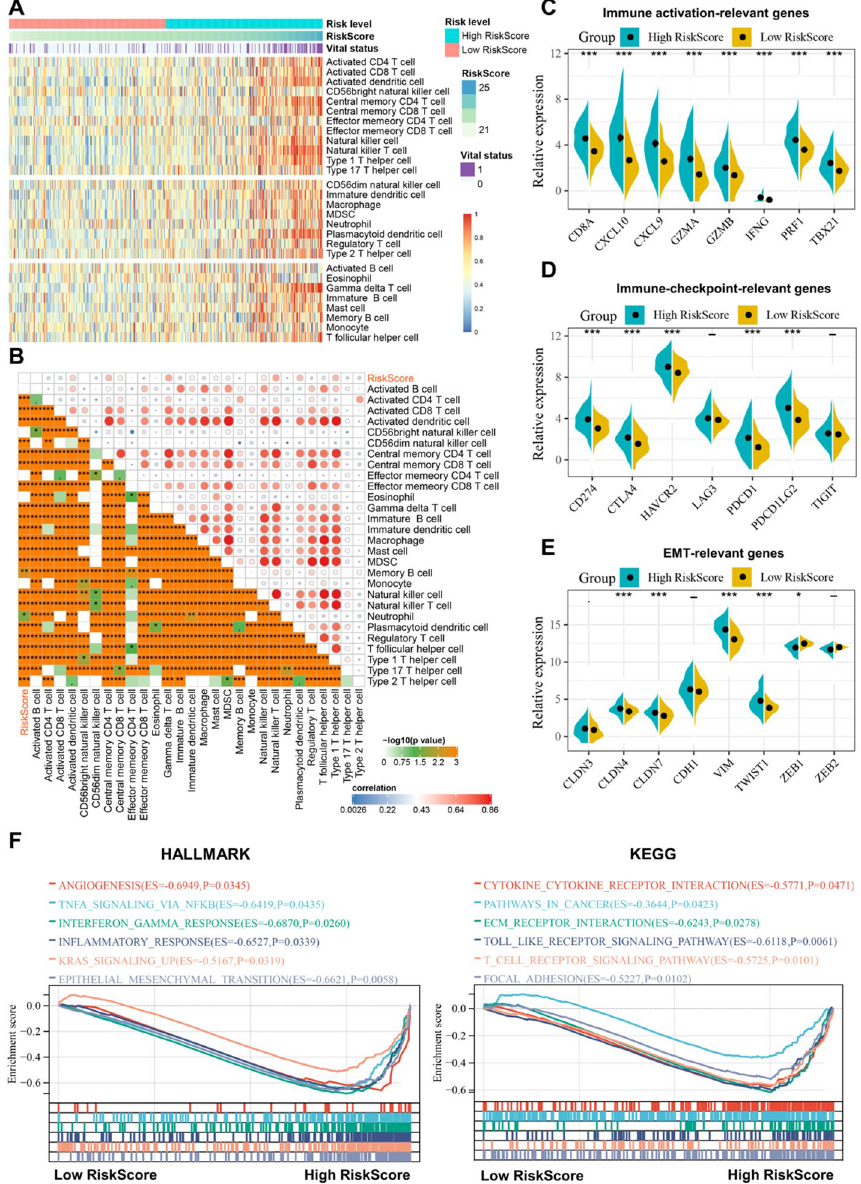
Fig. 9 Cellular and molecular characterization of RRG-related RiskScore. a Heatmap of the relationship between RRG-related RiskScore and 28 immune cell subpopulations identified by a previous study in the TCGA cohort. b Correlation between RiskScore and abundance of 28 immune cells. Correlations are calculated by spearman correlation analysis. Blue represents weak positive correlation, red represents strong positive correlation. c Immune activation-relevant genes (CD8A, CXCL10, CXCL9, GZMA, GZMB, IFNG, PRF1, and TBX21) expressed in high- and low-RiskScore groups. d Immune-checkpoint-relevant genes (CD274, CTLA4, HAVCR2, LAG3, PDCD1, PDCD1LG2, and TIGIT) expressed in high- and low-RiskScore groups. e EMT-relevant genes (CLDN3, CLDN7, CLDN4, CDH1, VIM, TWIST1, ZEB1, and ZEB2) expressed in high- and low-RiskScore groups. f Enrichment plots based on HALLMARK and KEGG gent sets showing the relatively significantly enriched pathways in high RiskScore group. Different pathways are indicated by different colors in each enrichment plot.